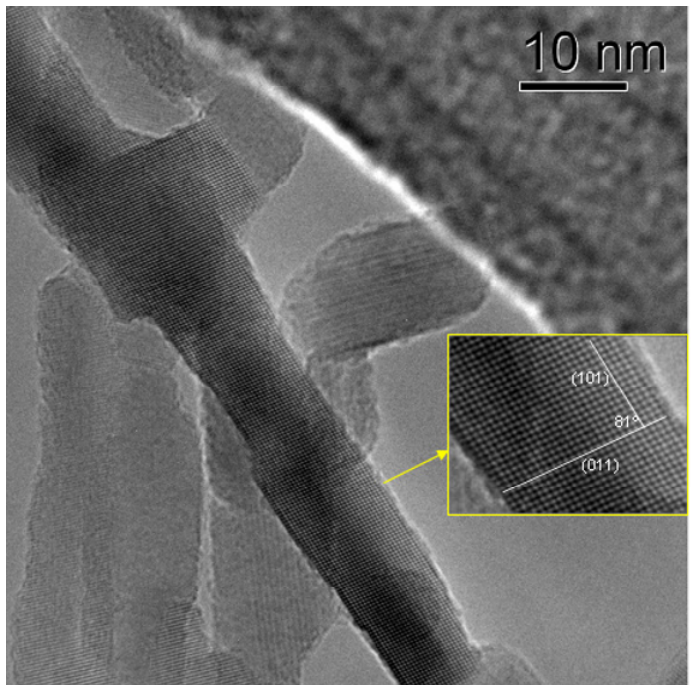
Figure 11. HRTEM image showing (101) and (011) planes in an anatase nanorod (sample